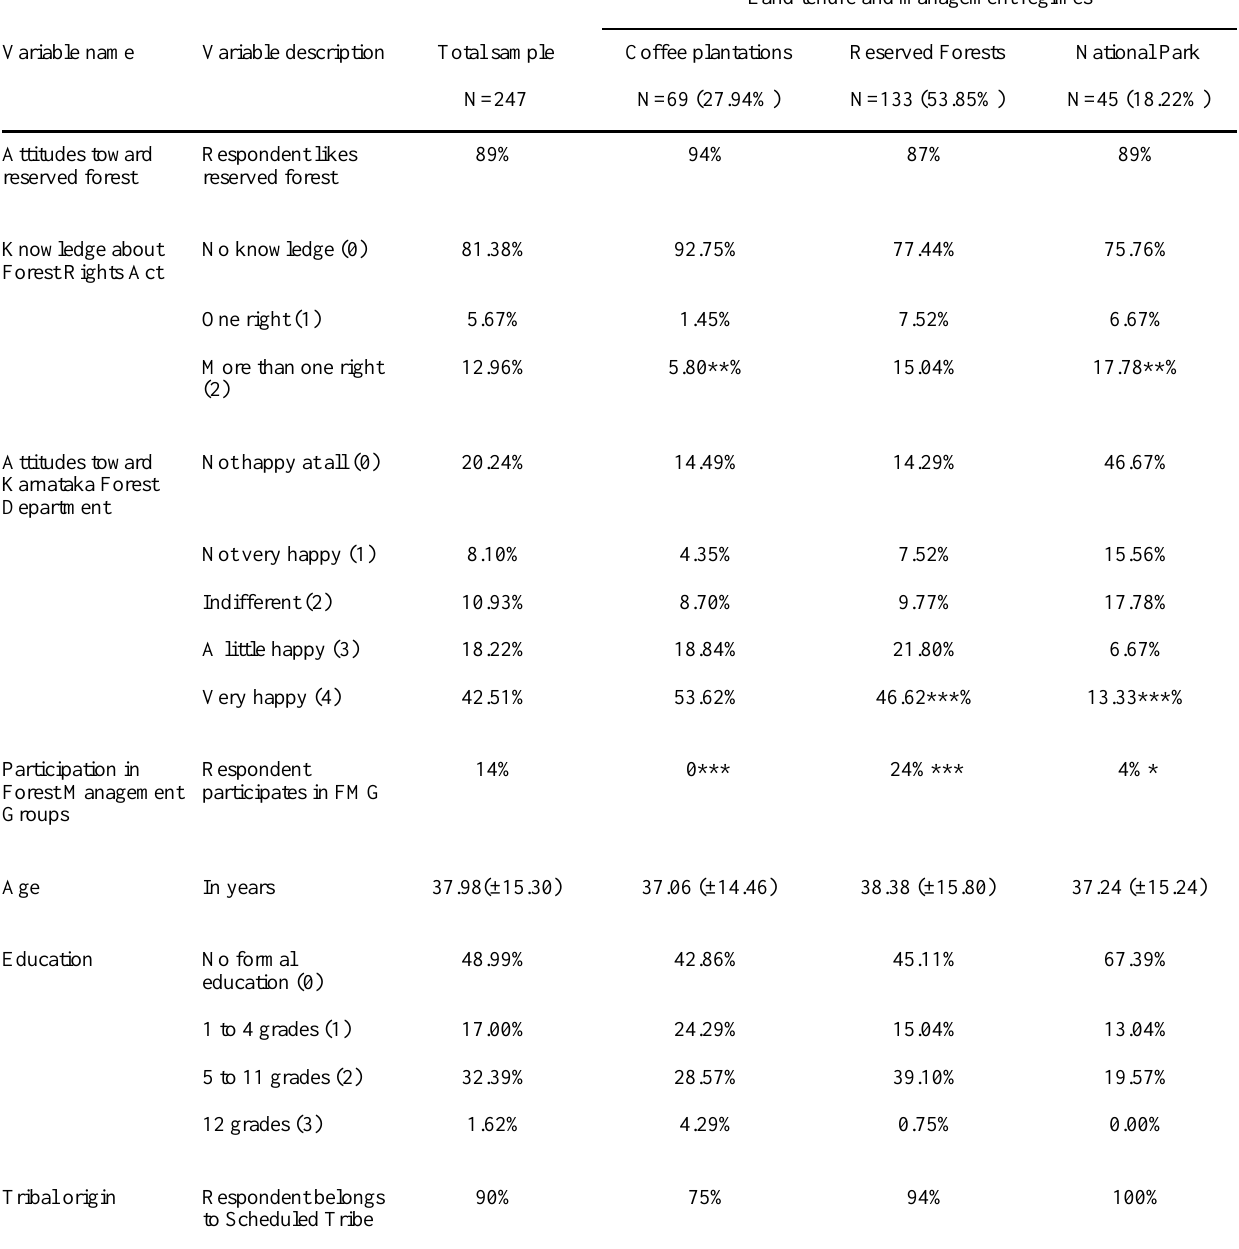
Table 1. Summary statistics of the variables included in the multivariate regression analysis (N = 247). Frequency distributions are listed for all the variables. For the attitudes toward reserved forests (dependent variable), Forest Rights Act knowledge, attitudes toward Karnataka Forest Department, and participation in forest management groups (independent variables) table shows comparisons within three land tenure and management regimes analyzed by likelihood-ratio chi2 tests (G2). Asterisks denote statistically significant relation * at 10%; ** at 5%; *** at